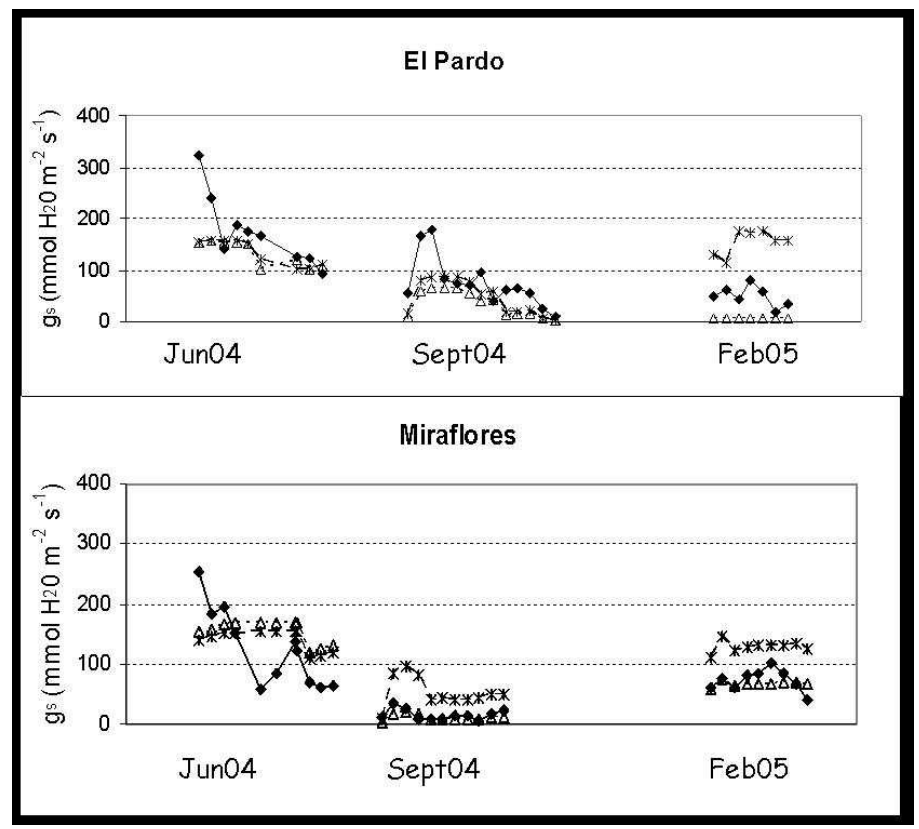
FIGURE 1 . Calibration of the g s model for Q. ilex using measured data at El Pardo and Miraflores during the period June 2004 to February 2005. ♦ , measured data; ∗ , calculated data based on literature review parameterization ; Δ calculated data based on literature review parameterization including f SMD